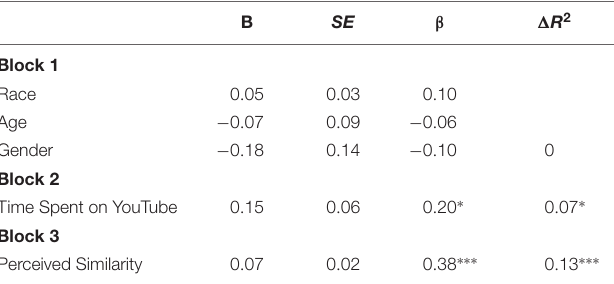
TABLE 3 | Summary of hierarchical regression for perceived similarity predicting wishful